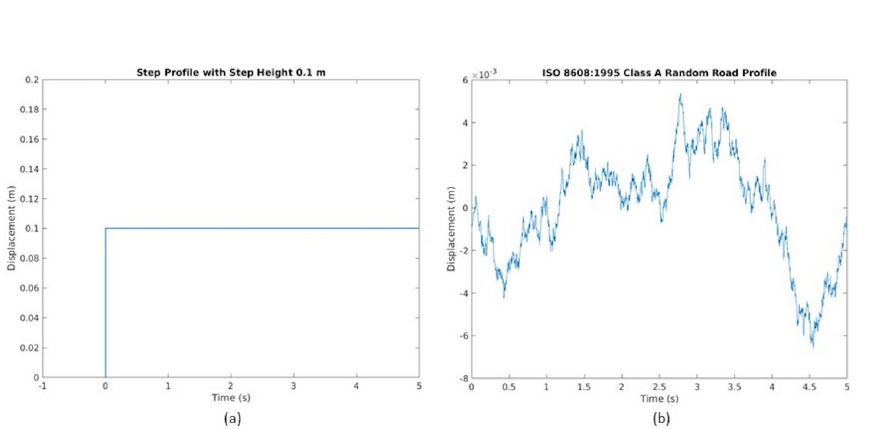
Fig 2. Representation of (a) step road profile of 0.1 m height and (b) random smooth road profile in the